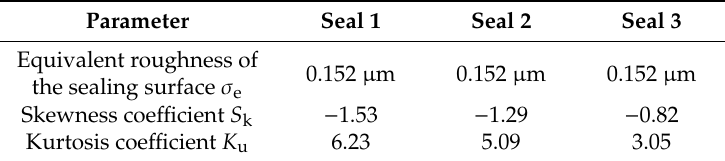
Figure 9. Probability density function ϕ(z). Table 2. Parameters of the mechanical face seals.